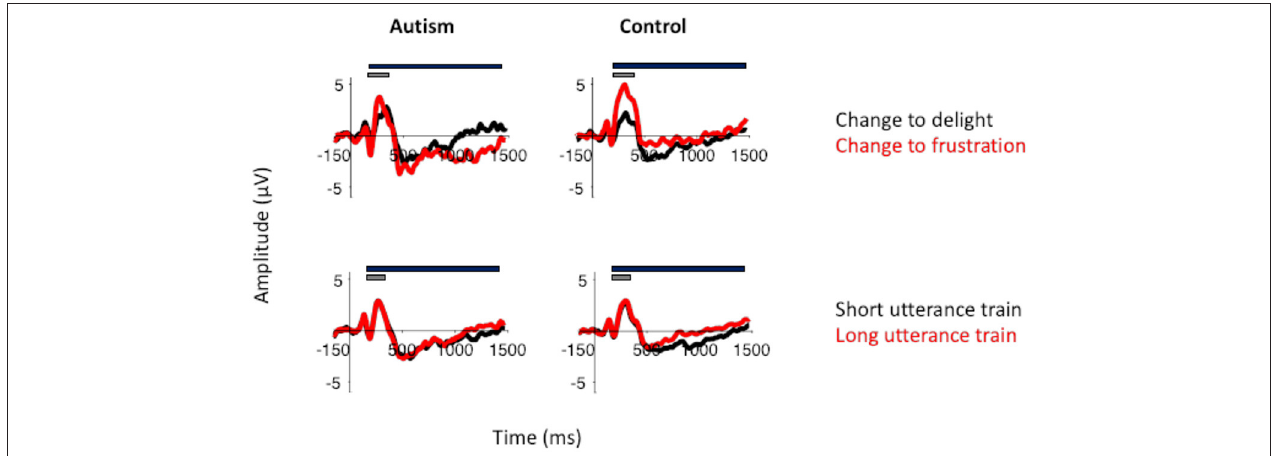
FIGURE 7 | Top row: P3 to the change in utterance to delight (black) and to frustration (red) in autism (left) and neurotypical controls (right). P3 was larger in response to frustration than to delight in controls. This was not the case for the adults with autism. Bottom row: P3 from the change in utterance after a short utterance train (black) and after a long utterance train (red). The gray bar indicates the window used for the peak amplitude analysis. The black bar indicates the window used for the TTV analysis. Both groups showed similar effects of adaptation in their P3 response.